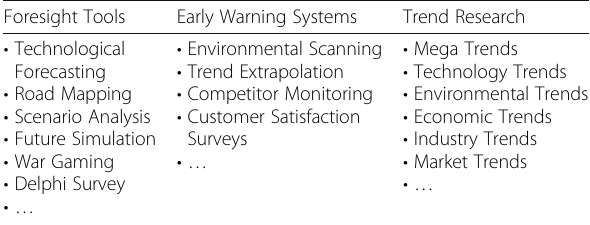
Table 4 The classification proposed by [16] Foresight Tools